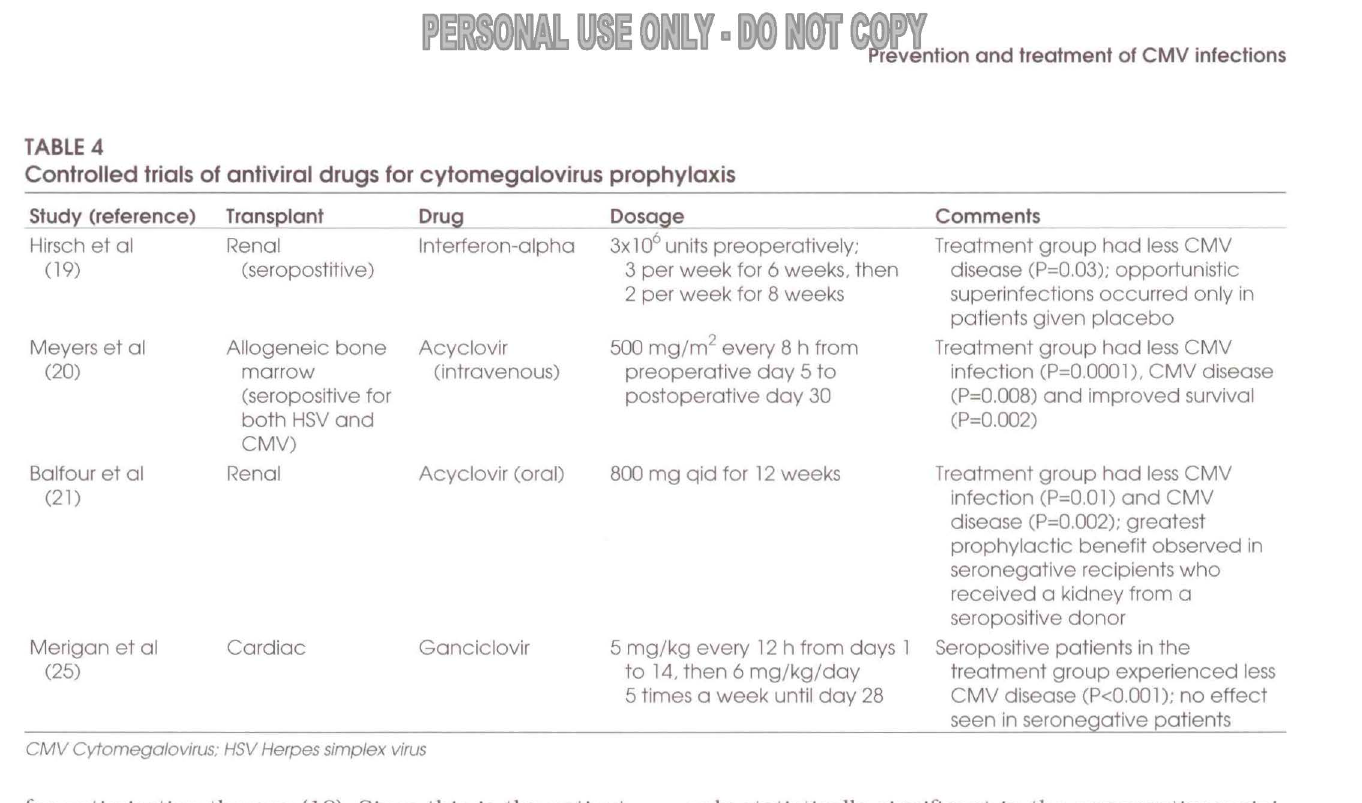
Controlled trials of antiviral drugs for cytomegalovirus